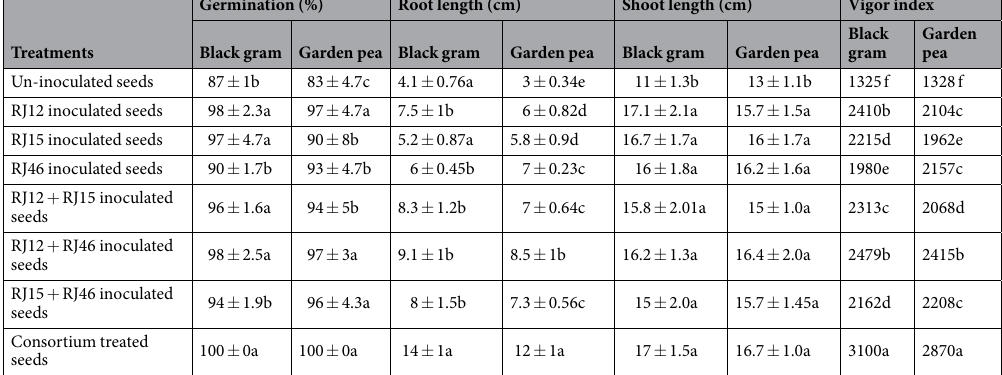
Table 2. Effect of bacterial inoculation on growth attributes of black gram and garden pea. (RJ12 - Ochrobactrum pseudogrignonense , RJ15 - Pseudomonas sp, RJ46 - Bacillus subtilis ). Means within a column sharing same lowercase letter are not significantly different according to Student’s t-test at p = 0.05; figures are means ± standard deviation (n = 5).